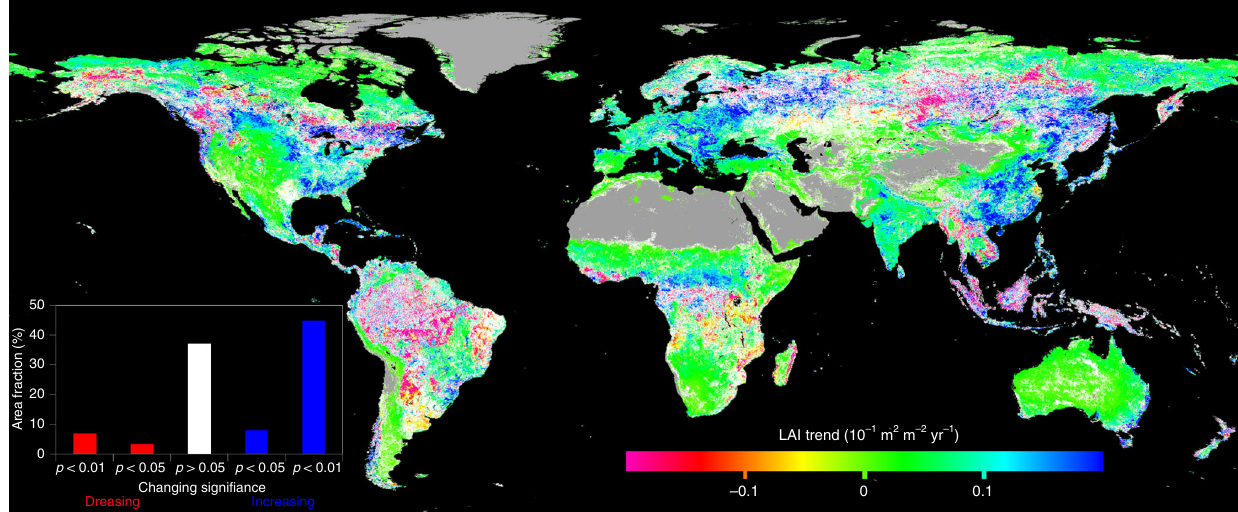
Fig. 1 Global map indicating the trend of LAI from 1981 to 2016. The gray color indicates non-vegetated areas and the white color denotes that the trend is statistically insigni fi cant ( p > 0.05). Positive values indicate increasing trends of growing season mean LAI and vice